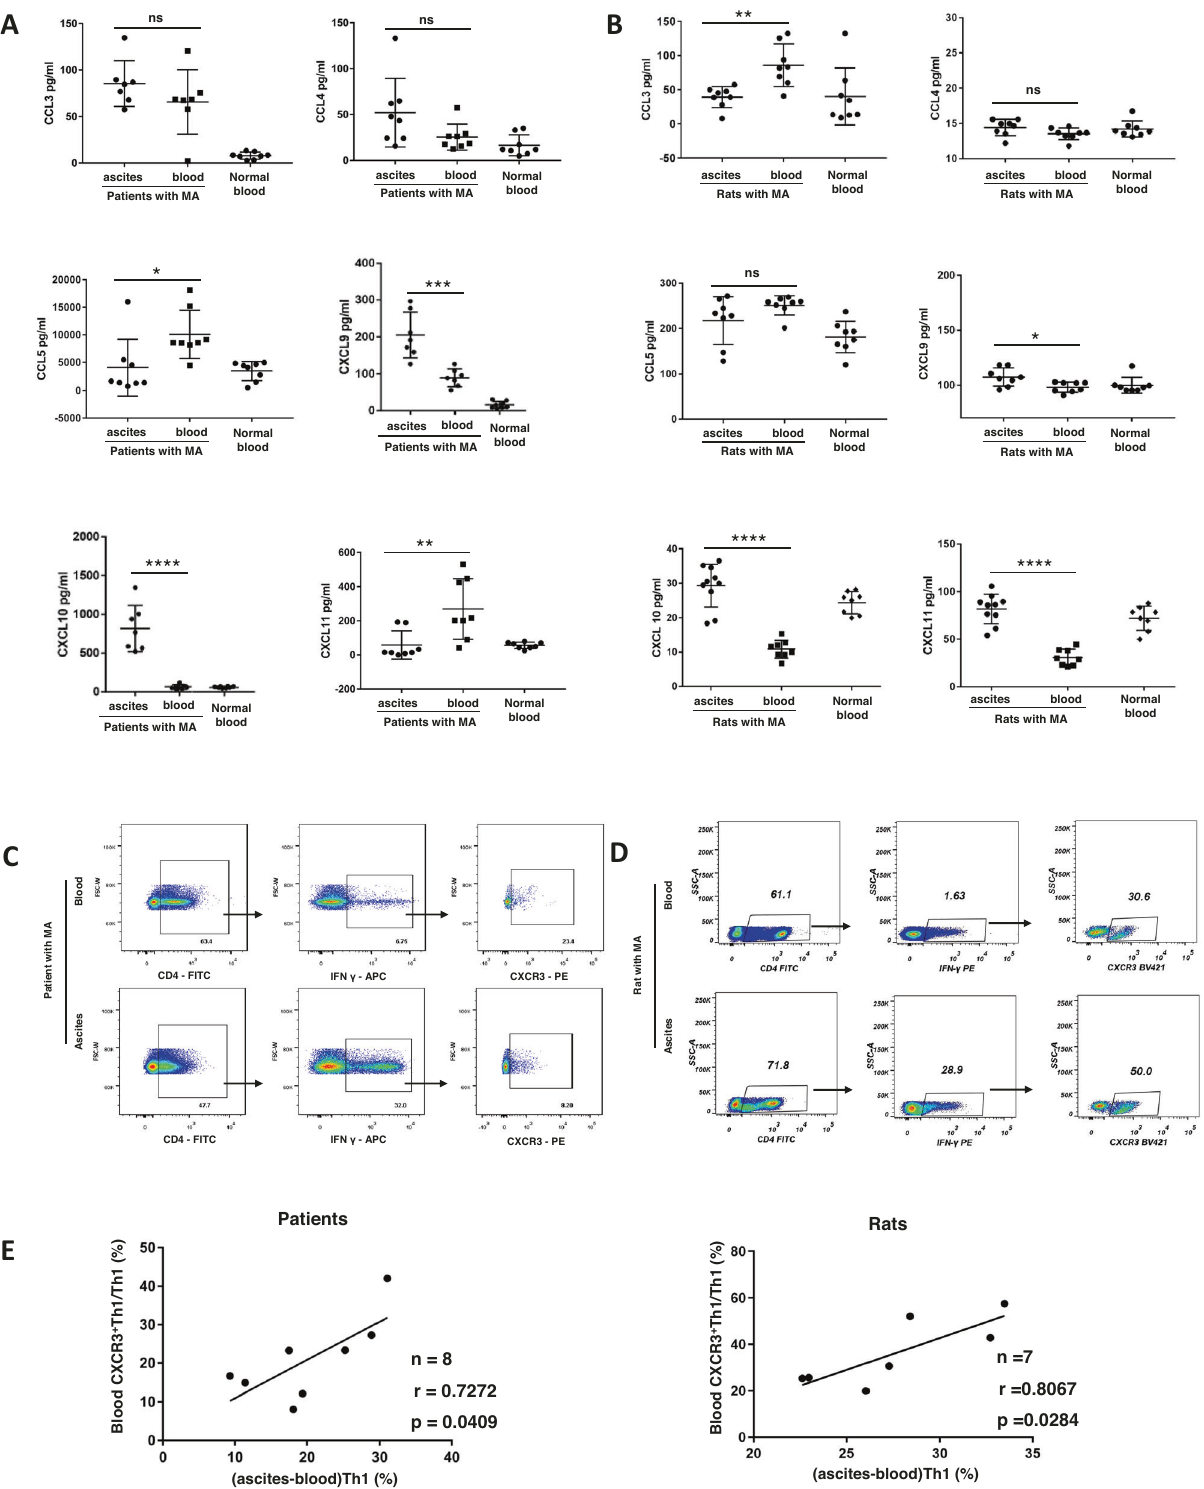
peritoneal cavity. In conclusion, our results demonstrated inter- feron γ produced by Th1 cell participated in the formation of malignant ascites through suppressing the growth of the tumor and reducing peritoneal permeability in vivo, and CXCL9,10/ CXCR3 axis mediated the recruitment of Th1 cells into peritoneal cavity through visceral peritoneum (Fig.